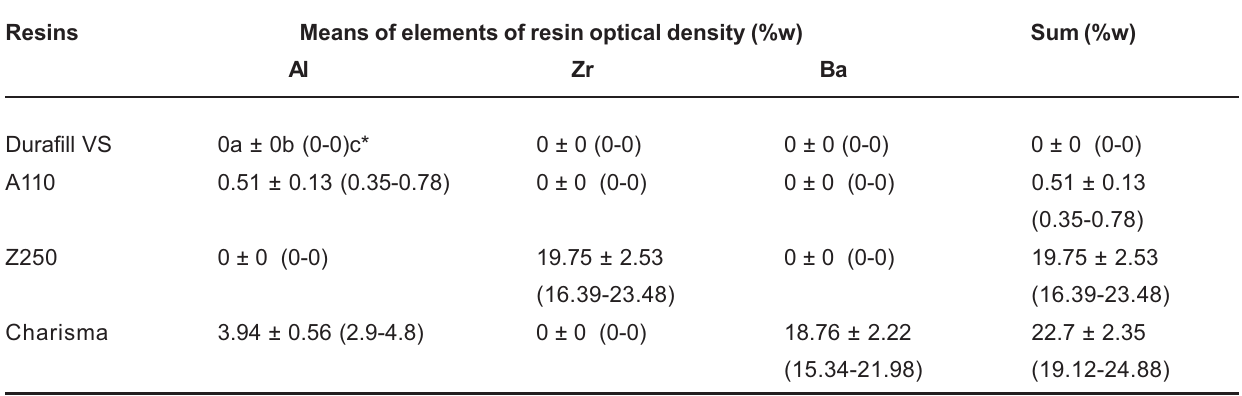
FIGURE 2 - Optical density means in the VixWin program of the DenOptix TABLE 3- Means and sum (% w) of elements of resin optical density